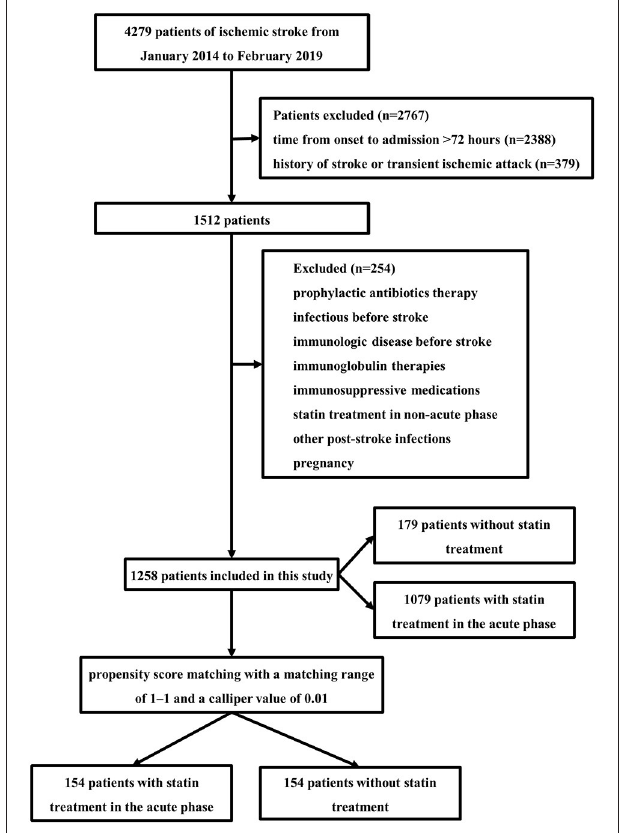
FIGURE 1 | Flow diagram of included